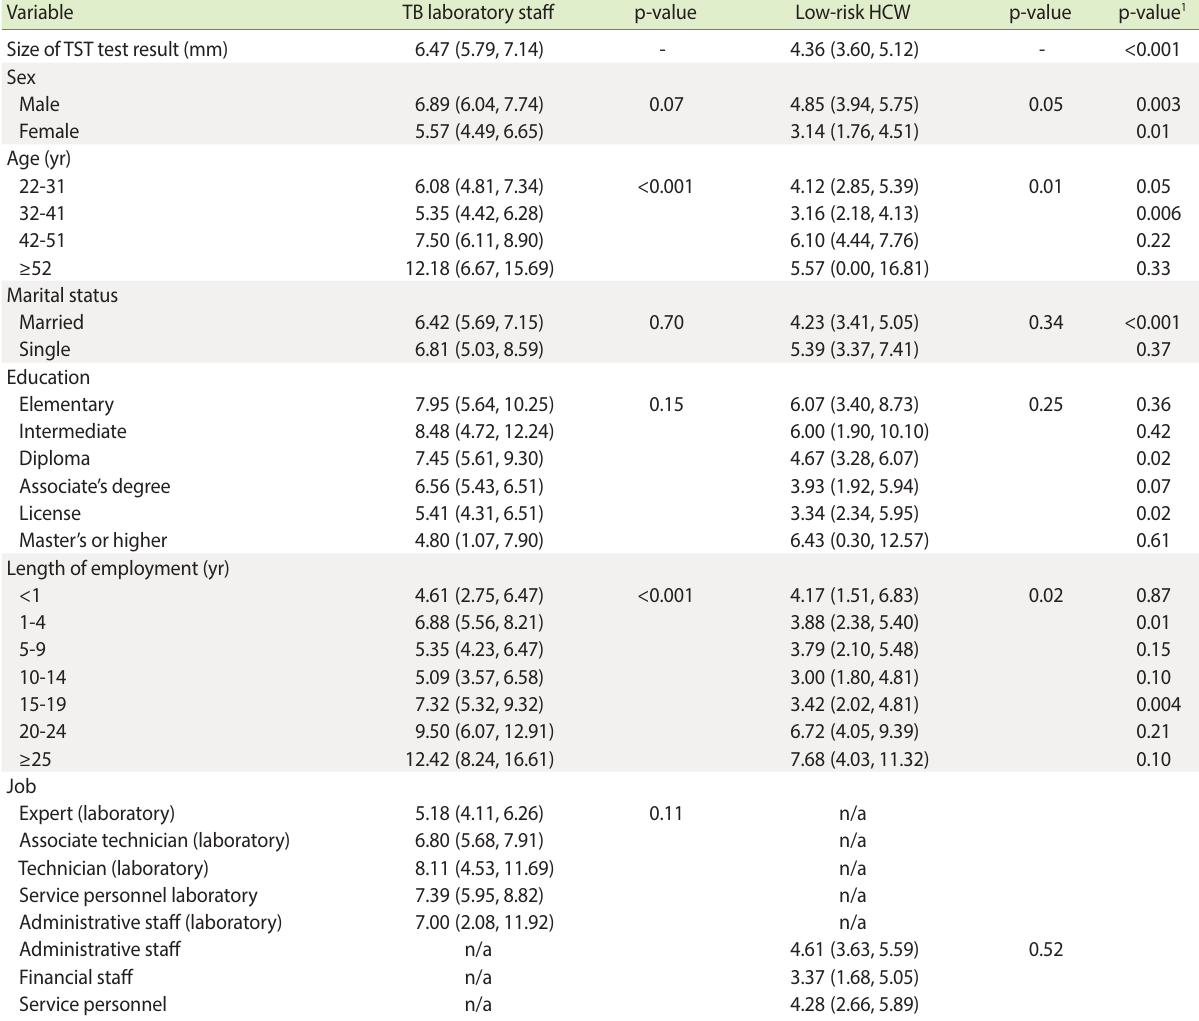
Table 2. Comparison of mean TST indurations among TB laboratory staff and low-risk HCW